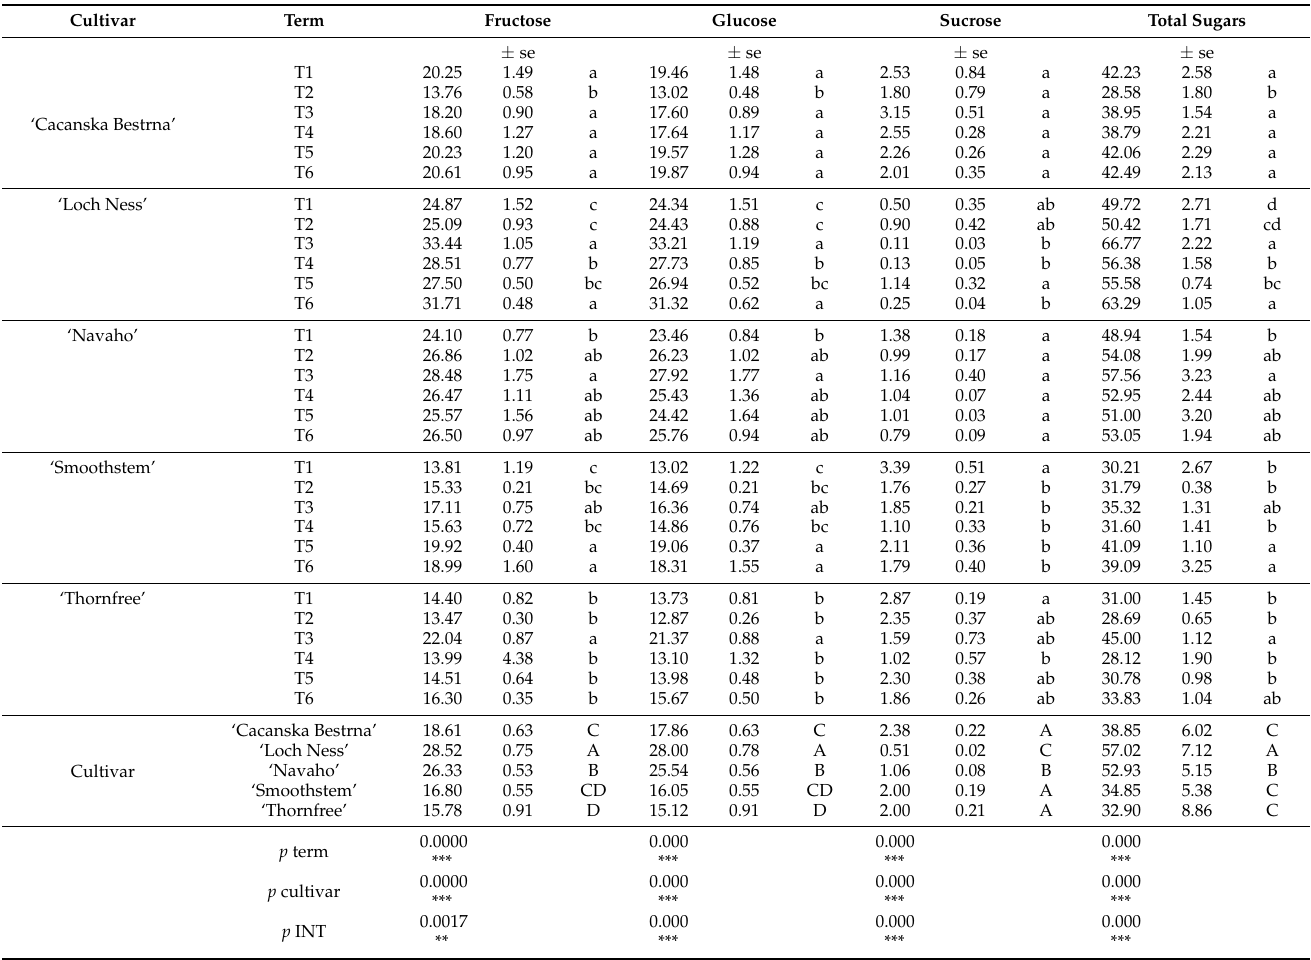
Table 2. The content of individual and total sugars (mean ± standard error in g/kg FW) of blackberry fruits and two-way ANOVA of harvest date, cultivar and interaction between harvest date × cultivar.